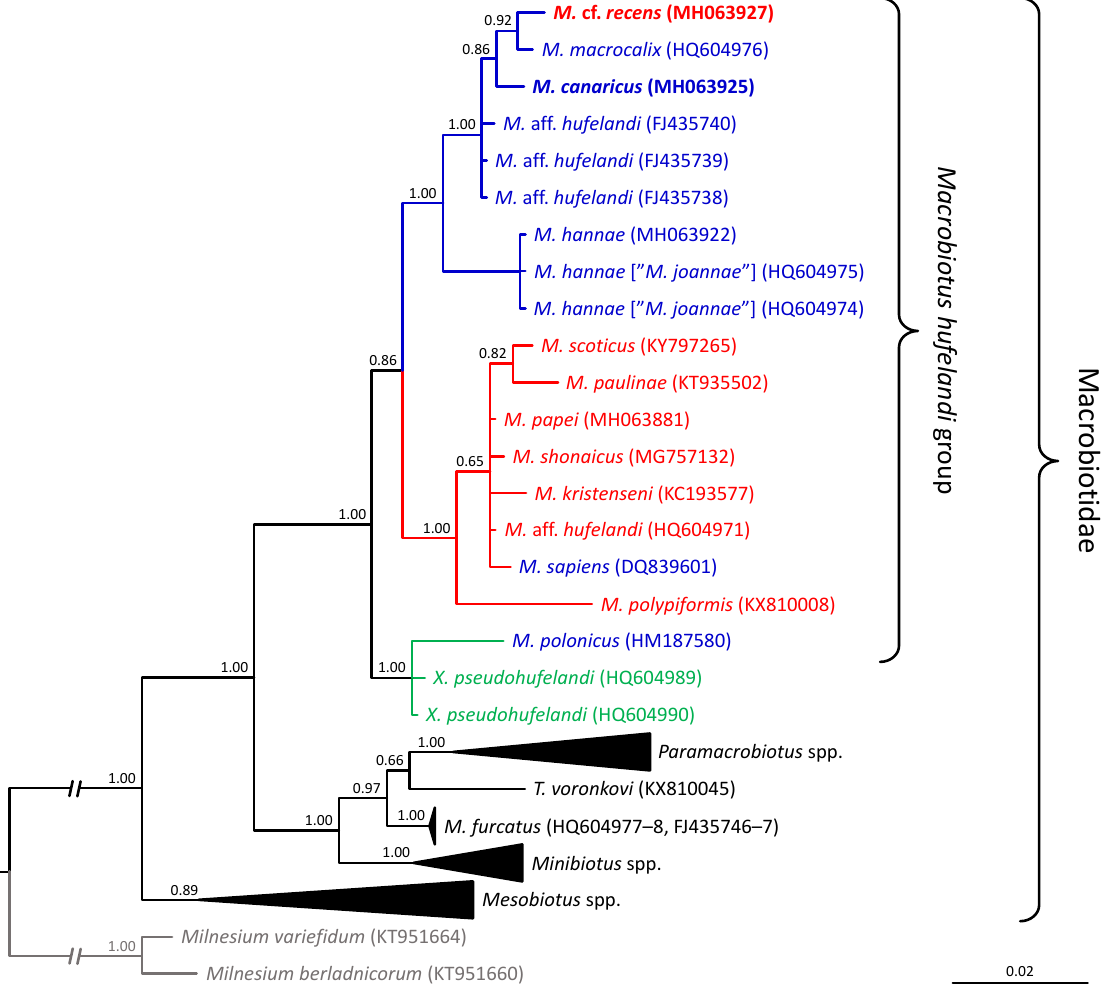
Fig. 15. The Bayesian Inference (BI) phylogeny constructed from 18S rRNA sequences of the family Macrobiotidae. Numbers at nodes indicate the Bayesian posterior probability. Species of the hufelandi group with typical and atypical egg processes are indicated by blue and red fonts, respectively. The X. pseudohufelandi + M. polonicus clade, which is in a sister relationship to all other species of the hufelandi group, is indicated by green branches. See Table 2 and the Phylogenetic analysis subsection in Material and methods for details on species sequences used in the analysis. The remaining macrobiotids are marked with black and the outgroup is marked with grey. Scale bar represents substitutions per